Question: What does this figure show? Answer in one sentence.
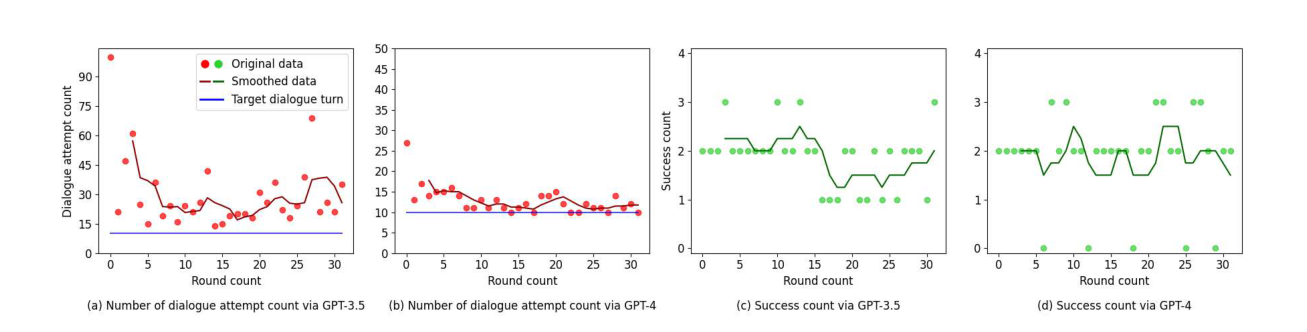
Answer: Scenario 3: Trends in forum discussion engagement on ALPS-Treated water issue. “Dialogue attempt count” in (a,b) refer to the number of rounds the agents attempted to converse(lower is better).